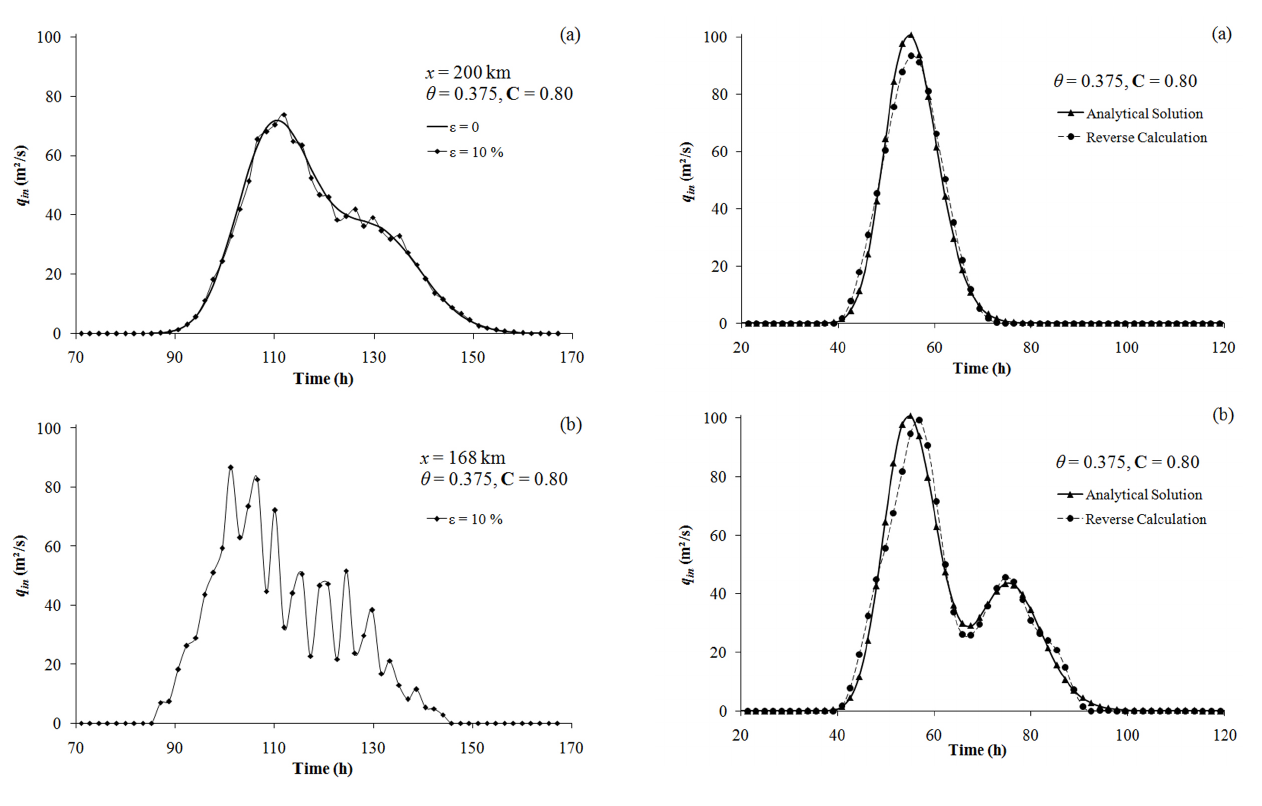
that data conditioning, via filtering, has enlarged the Courant number range relative to that shown in Fig. 3.